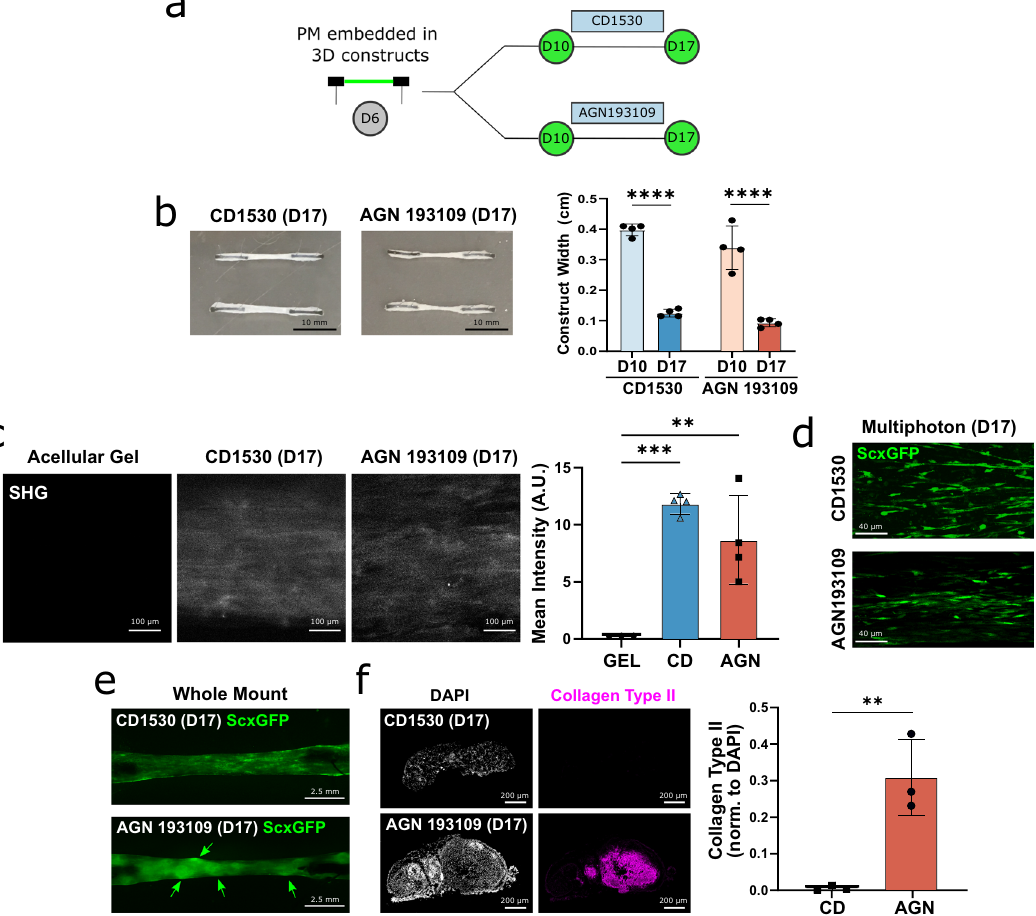
Fig. 6 3D static tension aligns cells and collagen deposition in engineered tendon and fi brocartilage tissues. a Schematic of experimental design. b Quanti fi cation of gel contraction over 17 days of culture in 3D ( n = 4 independent gels, one-way ANOVA with Tukey ’ s posthoc tests). Data represented as mean ± SD. c SHG imaging and quanti fi cation for aligned collagen deposition ( n = 4 independent gels, one-way ANOVA with Tukey ’ s posthoc tests). Data represented as mean ± SD. d Multiphoton imaging of aligned ScxGFP + cells at D17 under 3D conditions. e Whole mount ScxGFP fl uorescence imaging of 3D gels. f Immunostaining and quanti fi cation for collagen type II in transverse cryosections ( n = 3 independent gels, unpaired two-sided Student ’ s t-tests). Data represented as mean ± SD. ** p < 0.01, **** p < 0.0001. Source data are provided as a source data fi